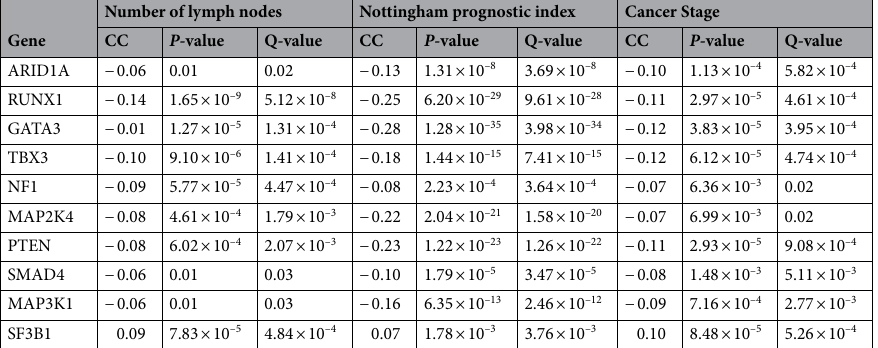
Table 5. Association between the expression of driver genes and the other clinical features. ARID1A, RUNX1, GATA3, TBX3, NF1, MAP2K4, PTEN, SMAD4, MAP3K1 and SF3B1 significantly associated with all of the three clinical features. The column ‘CC’ (i.e., correlation coefficient denoted by r ) measures the degree of association between the two variables: each driver gene versus each clinical feature. It takes on values ranging between − 1 and + 1. When r = 0, there is no relationship between the two variables. When r closer to 1, there is an increasingly strong positive (uphill) relationship between the two variables; otherwise, there is an increasingly strong negative (downhill) relationship between the two variables. CC: correlation